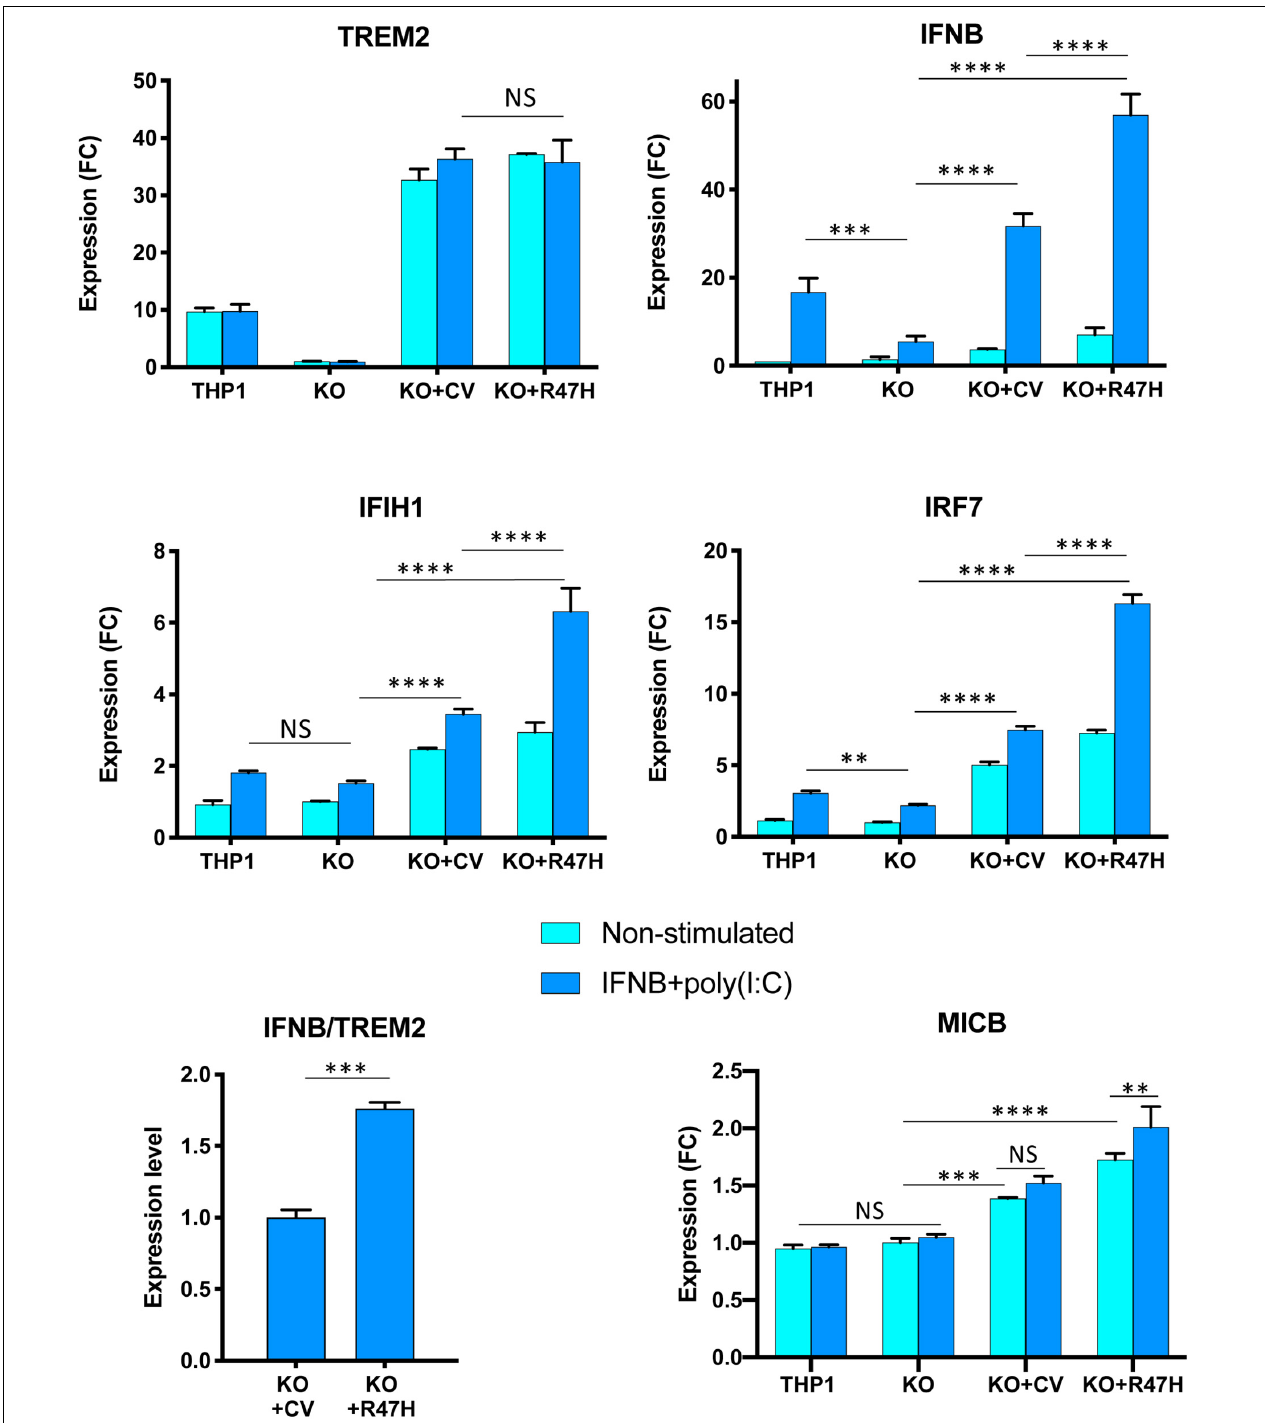
FIGURE 8 | Effect of TREM2 on key interferon (IFN) response genes and the NKG2D ligand MICB upon stimulation with a combination of poly(I:C) and IFN β . All cells were treated with doxycycline. Gene expression in non-stimulated cells and after 24 h stimulation was measured by qRT-PCR. THP1, unmodified cells; KO, TREM2 KO1 line; KO + CV, KO + R47H, TREM2 KO1 expressing common variant (CV) or R47H TREM2, respectively. Gene expression levels were normalized to expression in unstimulated KO. FC, fold changes. Assays were performed in biological triplicates and repeated two times; a representative experiment is shown. Data are shown as mean ± SD (NS, non-significant; ∗∗ p < 0.01; ∗∗∗ p < 0.001; and ∗∗∗∗ p < 0.0001, two-way ANOVA, Tukey’s multiple comparison test). Ratio of IFNB to TREM2 expression was calculated for TREM2 KO1 THP1 expressing either CV TREM2 or R47H TREM2 after 24-h poly(I:C) treatment from biological triplicates; data shown as mean ± SD ( ∗∗∗ p < 0.001, unpaired two-tailed t -test).